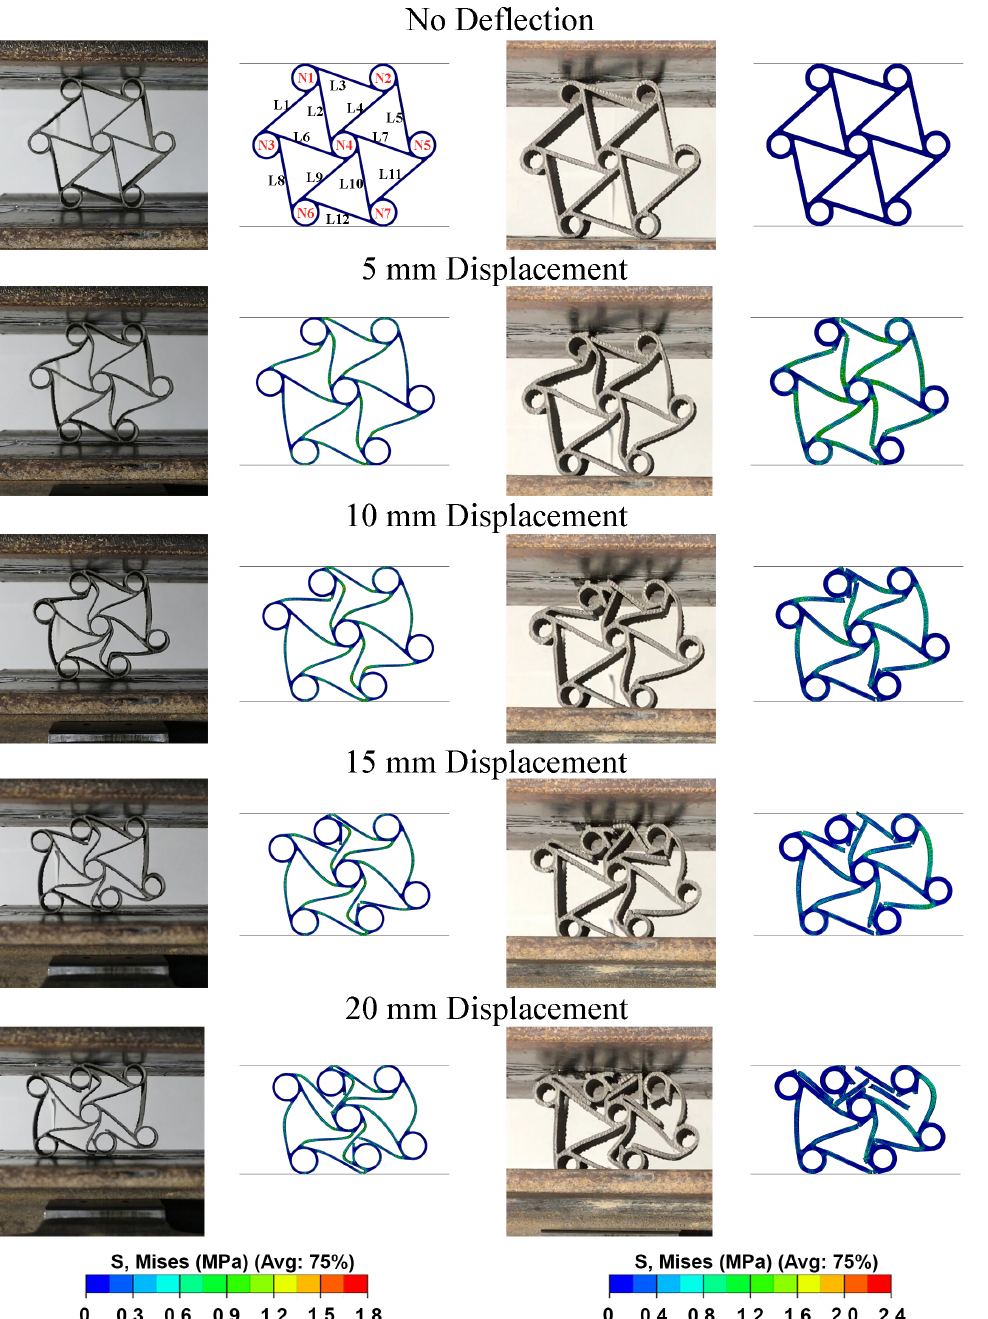
Figure 18. Comparison of FEM and experimental deformation stages for the crushing of chiral units with 0.8 mm and 1.6 mm